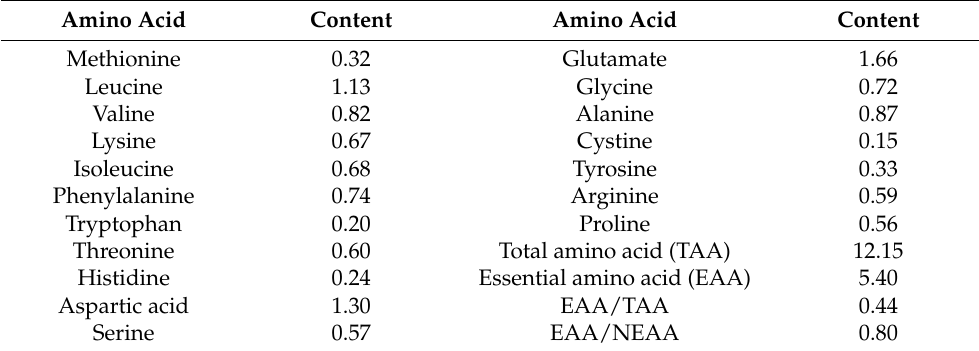
Table 3. Amino acid composition of Sargassum zhangii (g/100 g protein). Content Amino Acid